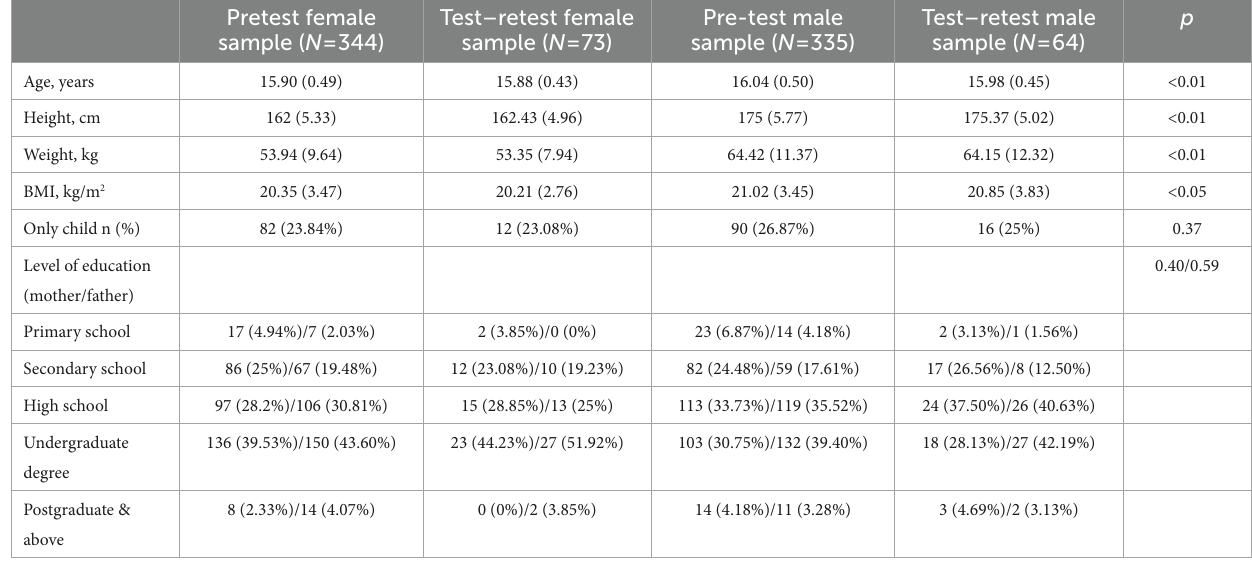
TABLE 1 Demographic information for all